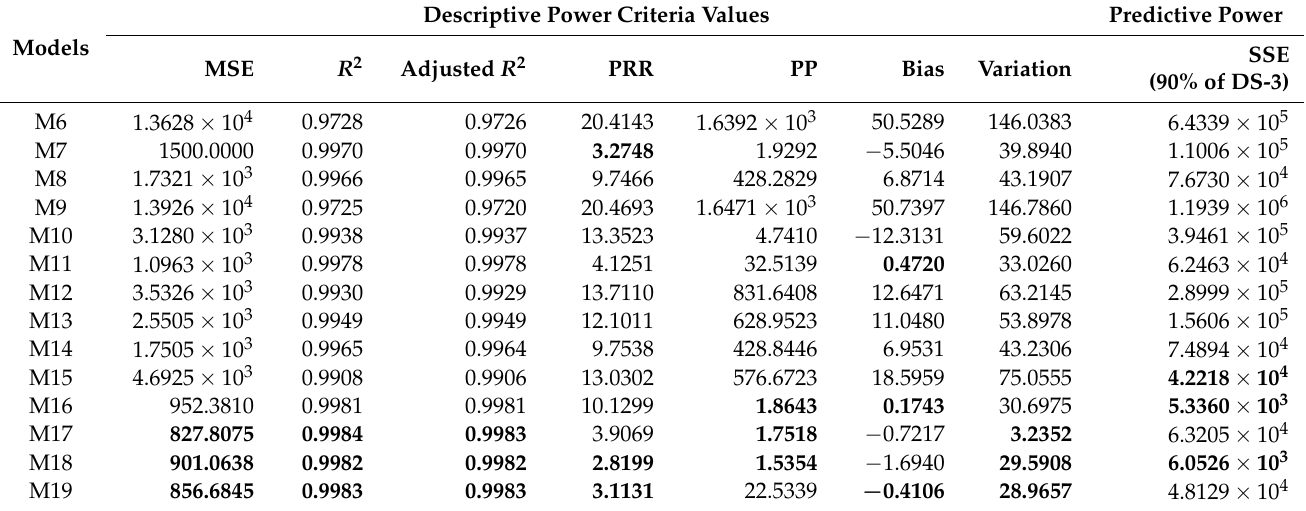
Table 7. Comparisons of descriptive and predictive power of M6 to M19 for DS-3. Descriptive Power Criteria Models